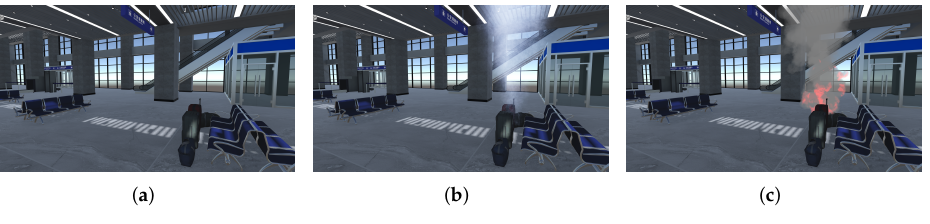
Figure 2. Stimuli. ( a ) Alarm, ( b ) Smoke, ( c ) Flame.